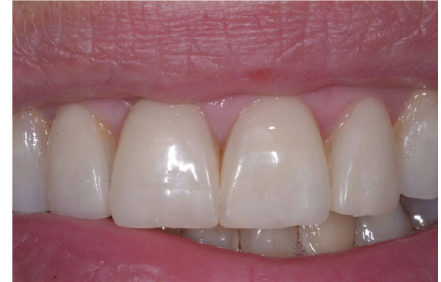
Figure 15: Evaluation of the shade and fit using try-in